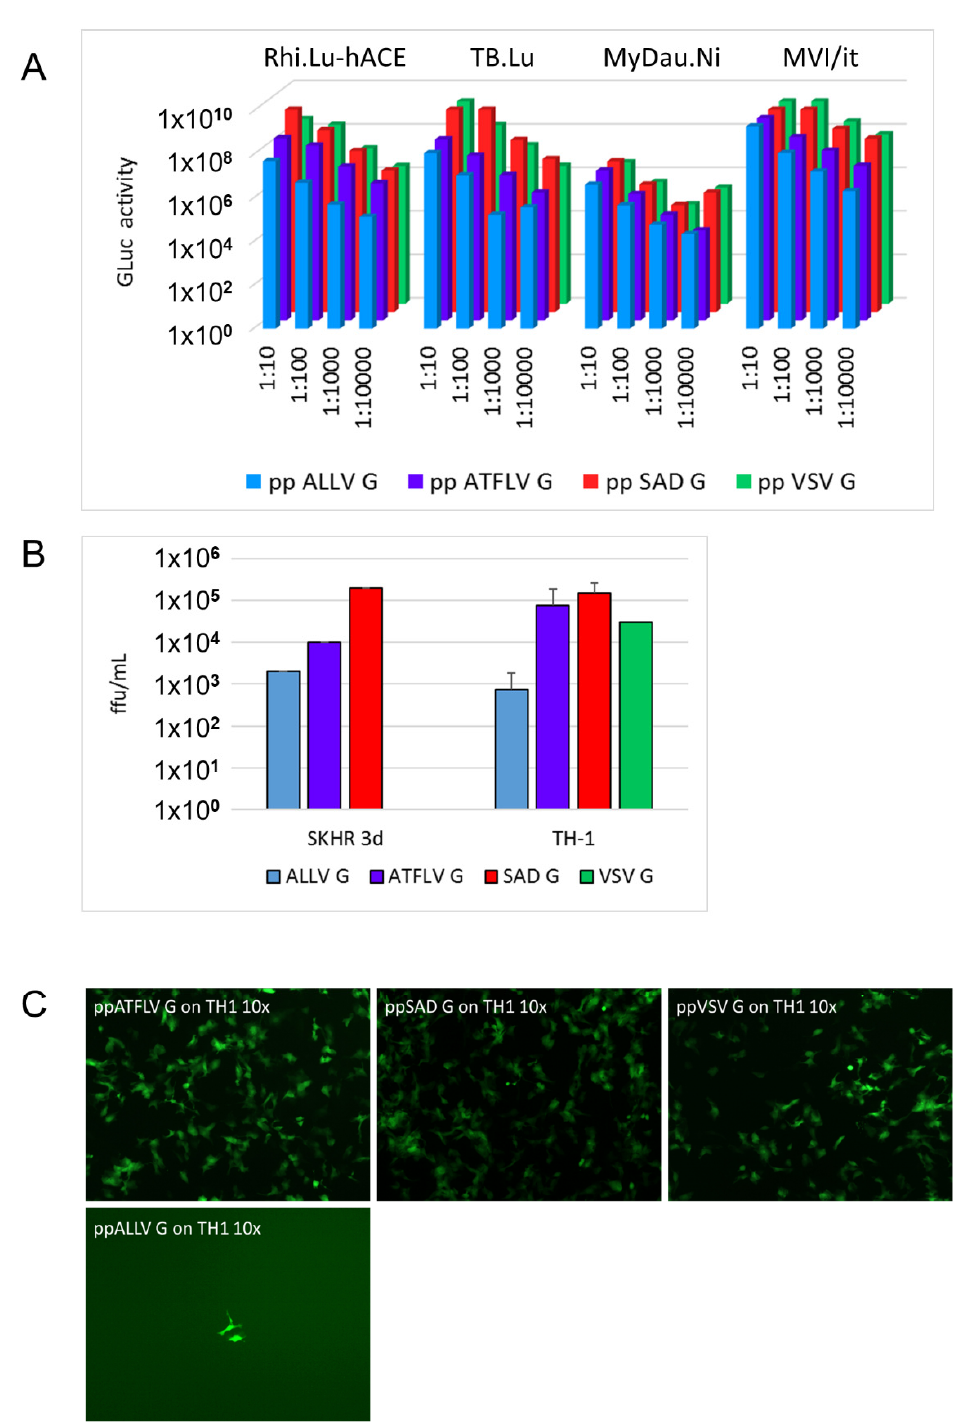
Figure 4. ALLV and ATFLV G pp can infect bat and reptile cells. ( A ) The indicated bat cell cultures were incubated with serial dilutions of RABV pp stocks (SAD ∆ G-GLuc-mNeongreen), and Gaussia luciferase activity was determined after 3 d.p.i. (Rhi-Lu-hACE2, Rhinolophus sp. lung, expressing hACE2; TB1-Lu, Tadarida brasiliensis lung; MVI/it, Myotis velifer incautus; MyDauNi/2, Myotis daubentonii ). Note that reduction of activity of ATFL and ALLV with respect to SAD G RABV pp (red) roughly correlates with physical titers observed in Figure 3. ( B ) Infection of reptile cells. Common box turtle (TH-1) and red-eared slider snake (SKH-R) cell lines were infected with the indicated RABV pp stocks (SAD ∆ G-GLuc-mNeongreen) and titers were determined by counting fluorescent cells 3 d.p.i. Note that ATFL pp reaches titers almost equivalent to SAD G pp. ( C ) Representative micrograph of TH-1 cultures infected with 1:10 dilutions of RABV pp